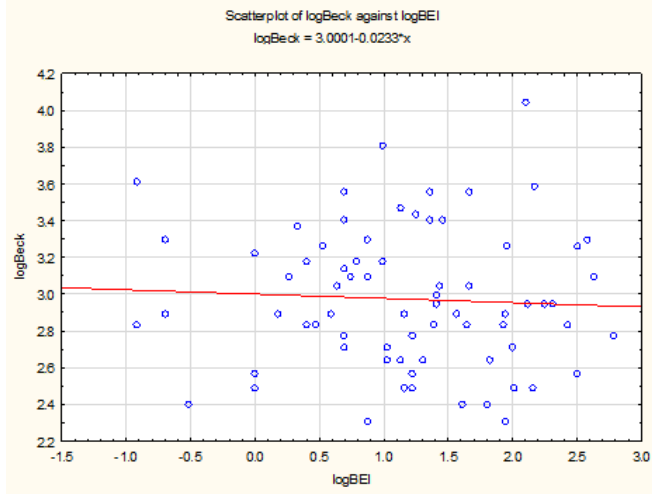
Figure 3. Relationship between BEI and Beck’s Depression Inventory (BDI) values.